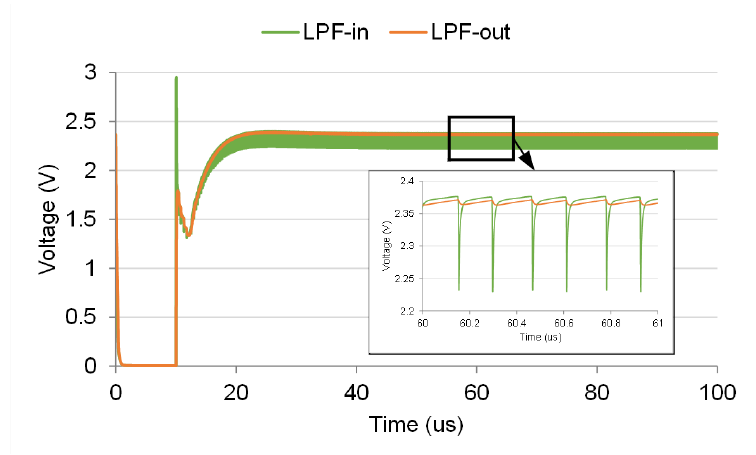
Figure 10. Post-layout simulation results of the input and output voltages of LPF.